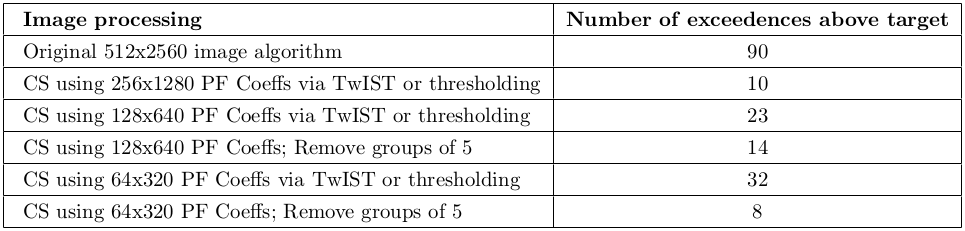
Table from the paper: How to find real-world applications for compressive sensing
Table text:
Imageprocessing
Numberofexceedencesabovetarget
Original 512x2560 image algorithm
90
CS using 256x1280 PF Coeﬀs via TwIST or thresholding
10
CS using 128x640 PF Coeﬀs via TwIST or thresholding
23
CS using 128x640 PF Coeﬀs; Remove groups of 5
14
CS using 64x320 PF Coeﬀs via TwIST or thresholding
32
CS using 64x320 PF Coeﬀs; Remove groups of 5
8